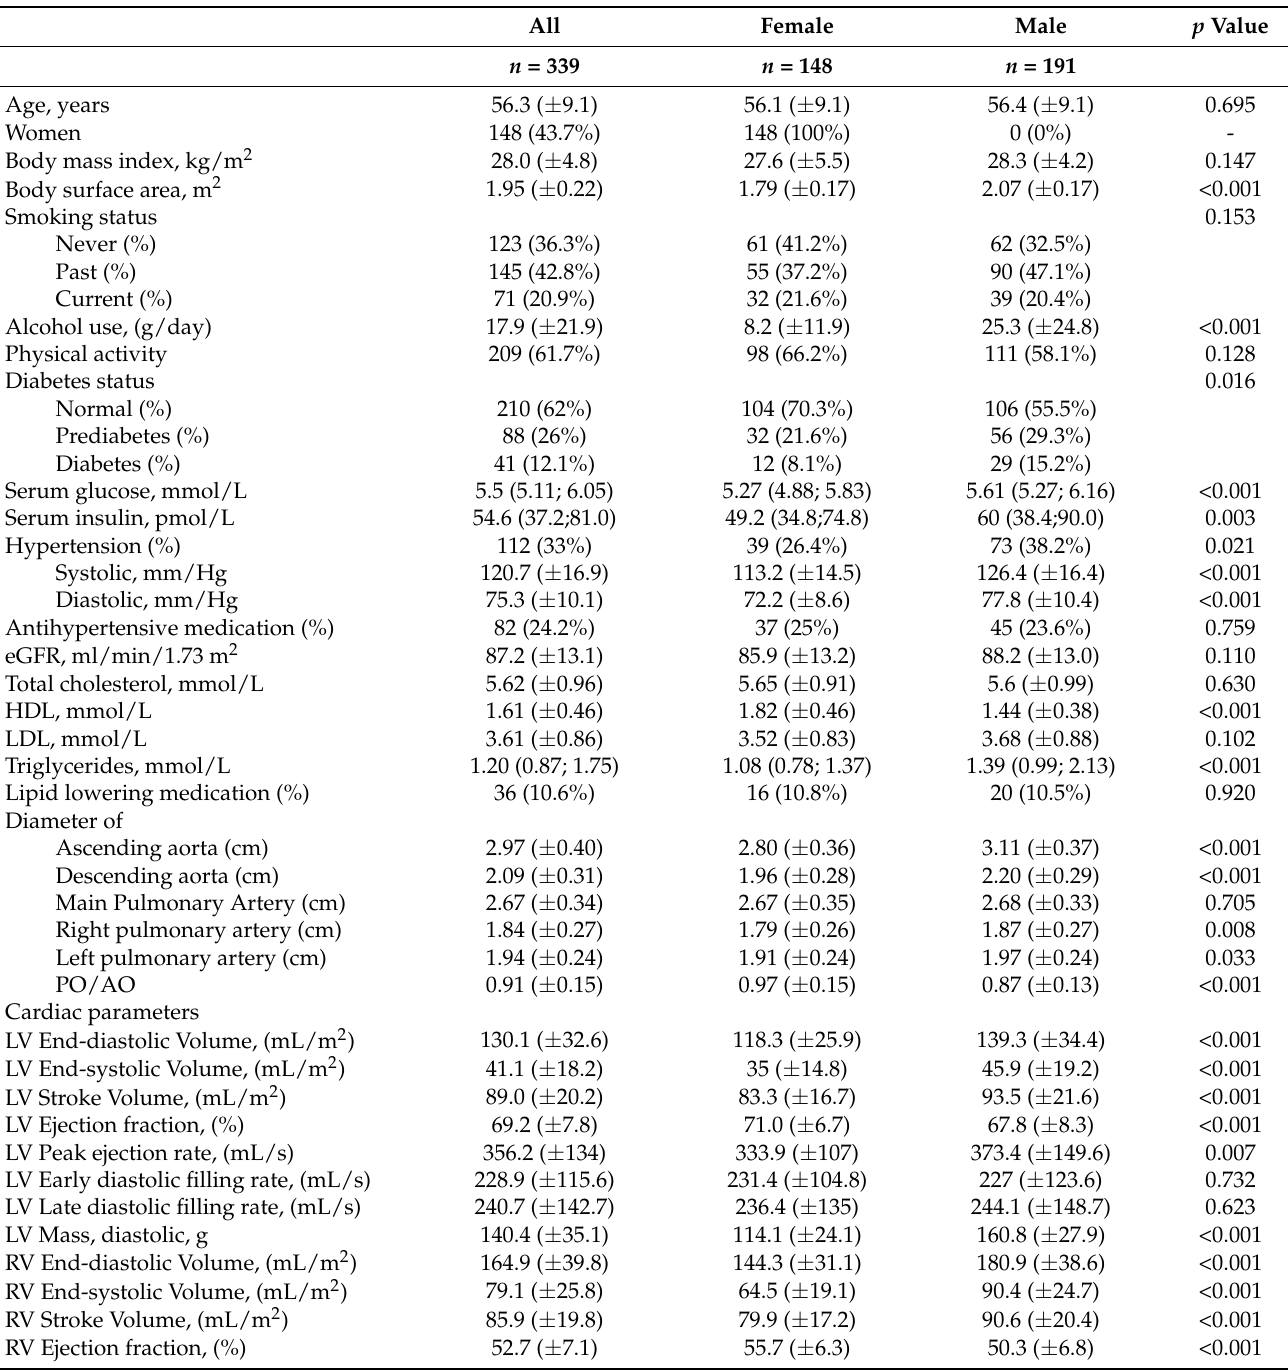
Table 1. Study population